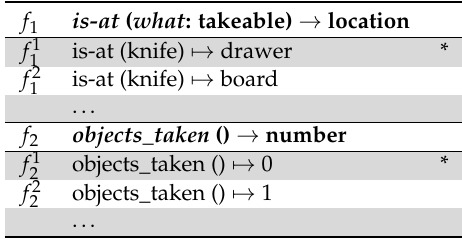
Table 3. Result of step 3: A list of functions with type signatures and their instantiations. A * in the last column means that the defined function holds in the initial